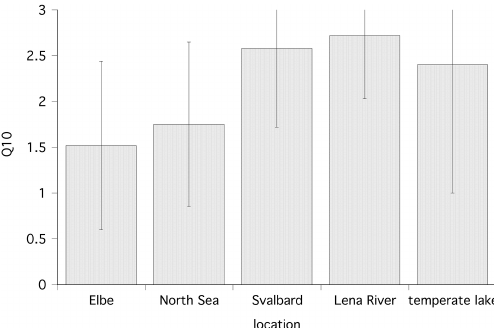
Figure 6. Temperature dependence ( Q 10 ) of the methane oxida- tion rate at different locations; shown are the mean and standard deviation. Data for the Elbe and North Sea are from Bussmann et al. (2015), and data for the temperate lake are from Thottathil et al.